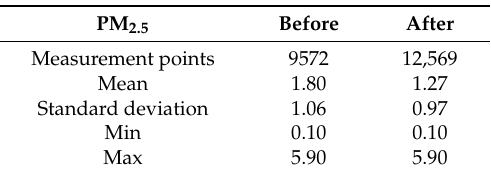
Table 6. PM 2.5 concentrations in Classroom 3 before and after the ventilation intervention: Statistical parameters. PM 2.5 Before After Measurement points 9572 12,569 Mean 1.80